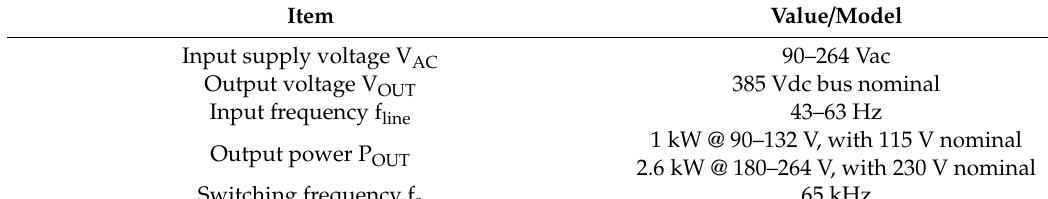
Figure 9. Perspective of the hardware prototype: ( a ) bird’s eye view; ( b ) top side view. Table 1. The specification and the parameters of the design.